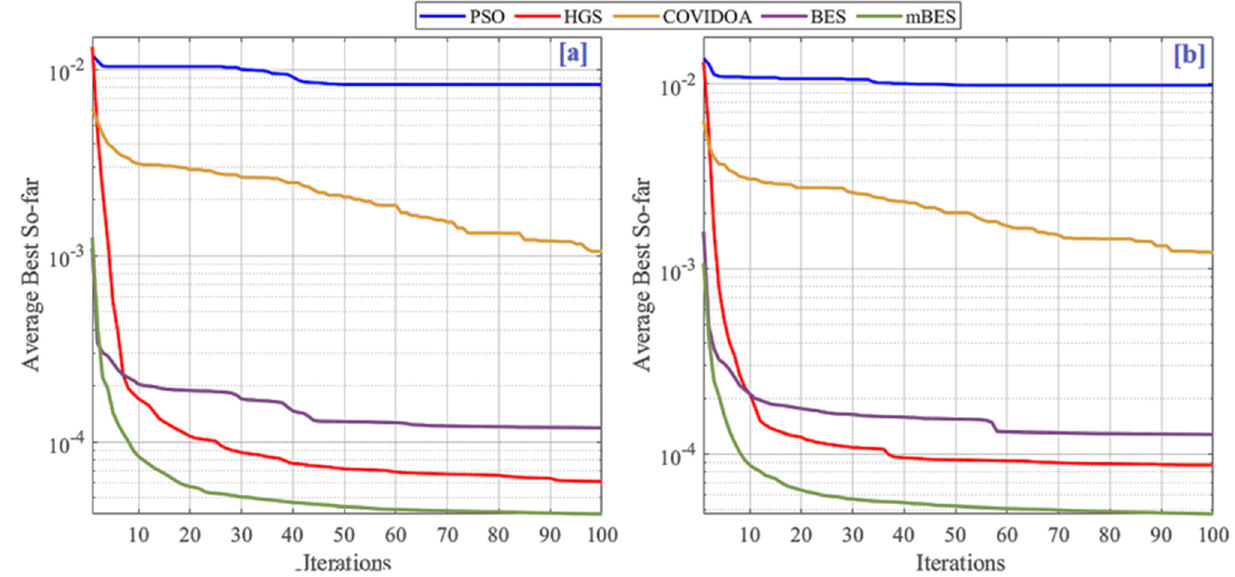
Figure 5. Convergence curves of parameter identification using different algorithms: ( a ) control PSC and ( b ) modified PSC.